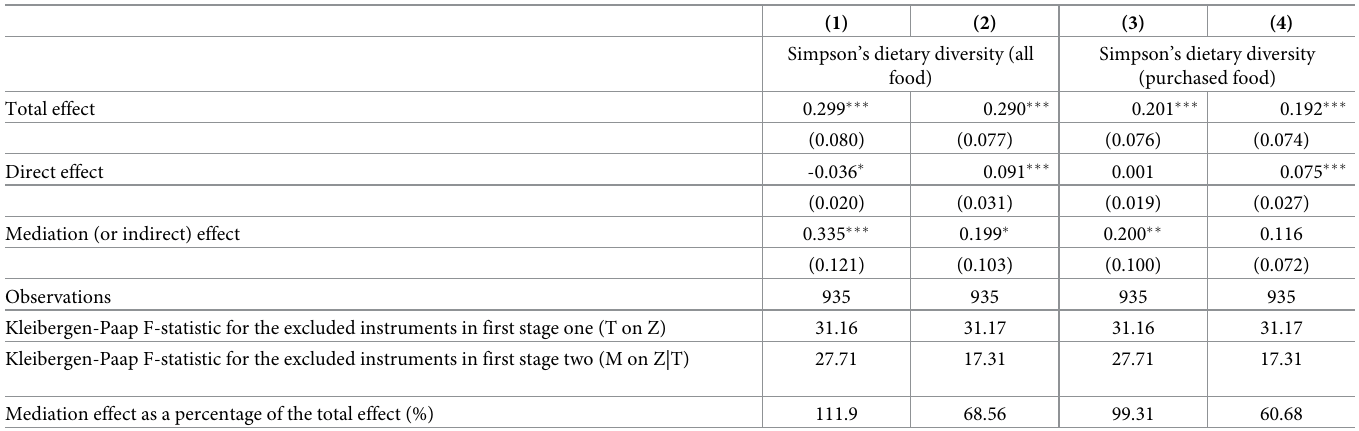
Table 4. Impact of program participation on dietary diversity, as mediated by the value of maize and pulse